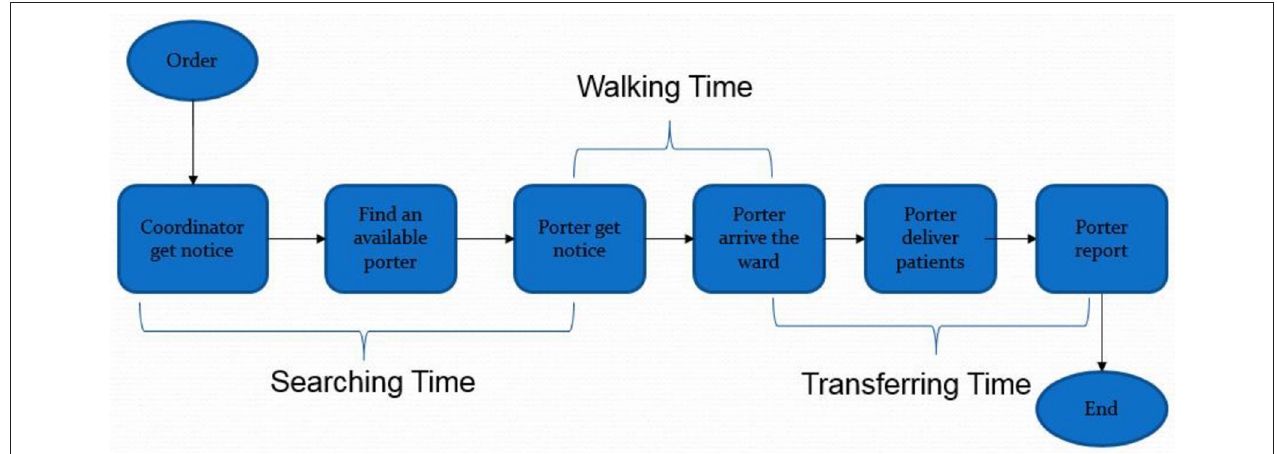
FIGURE 1 | Process of patient-flow. Source: Friesen et al. (58).